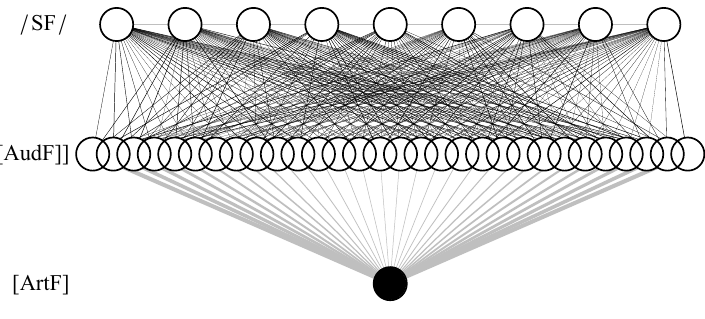
Figure 24: The initial state of the neural